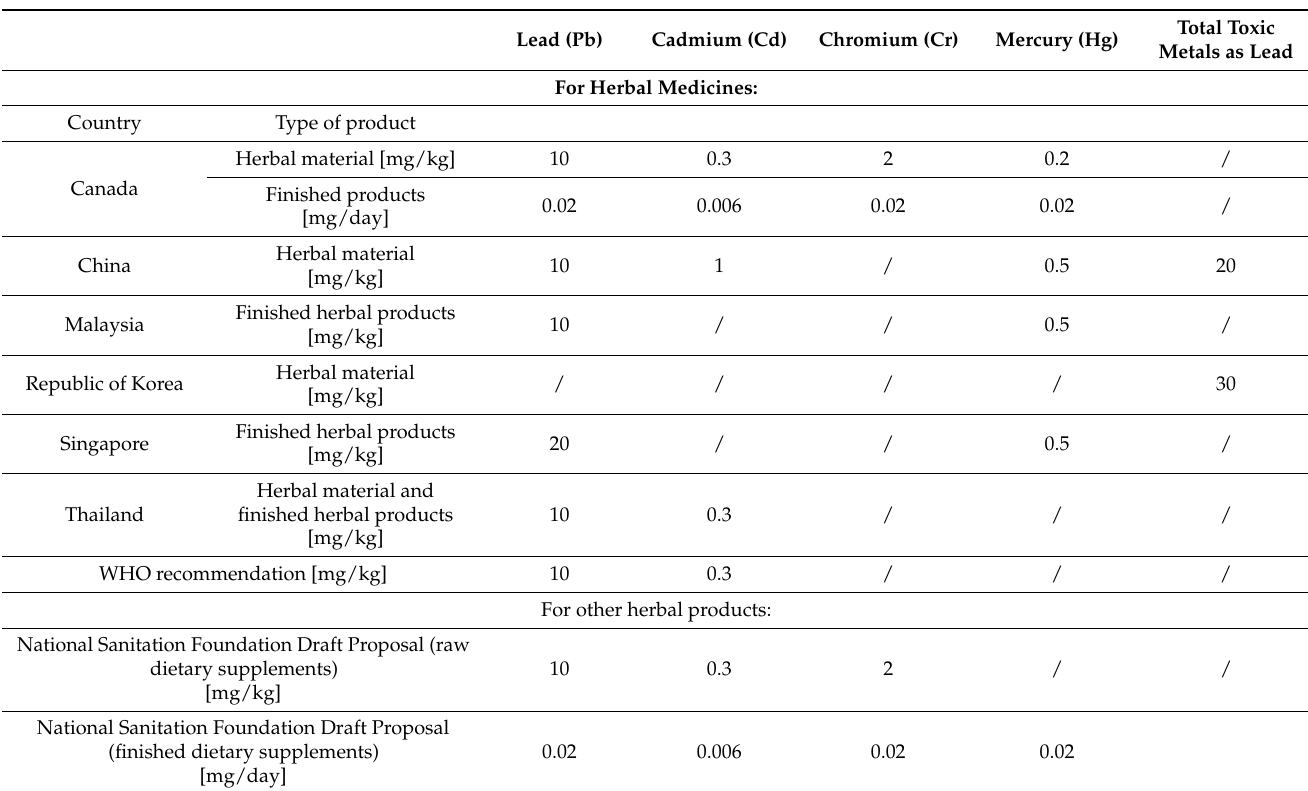
Table 3. The national limits of concentrations for toxic metals in herbal medicines and products (World Health Organization 2007) [38]. Lead (Pb) Cadmium (Cd) Chromium (Cr) Mercury